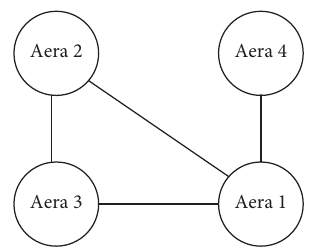
Figure 6: Structure of the studied four-zone power